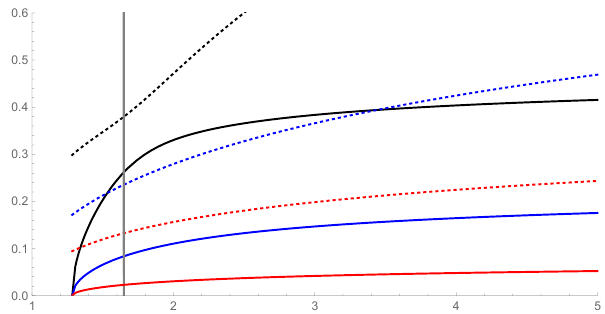
= (cid:0) 0 : 5 ; (cid:0) 1 : 5 ; (cid:0) 1 : 75 for the black, b